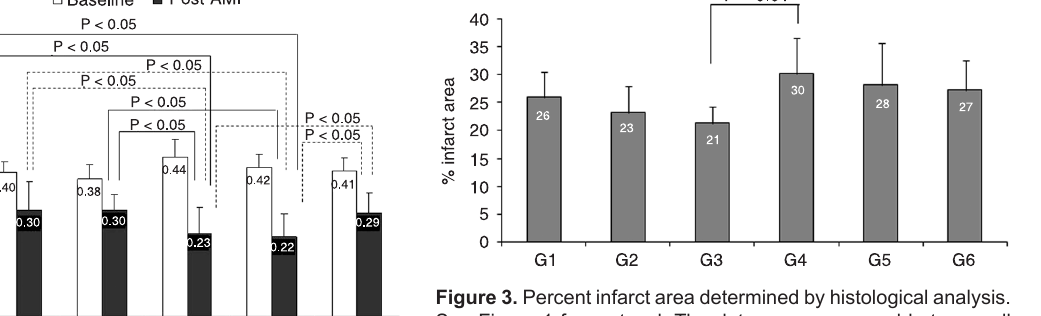
Figure 3. Percent infarct area determined by histological analysis. See Figure 1 for protocol. The data were compared between all groups. The variables measured in only one condition were evalu- ated by analysis of variance (ANOVA) with a classification factor, when significant. The Tukey test was applied to determine differ- ences between groups. Table 3. Biochemical data at baseline and after left anterior de- scending (LAD) coronary artery